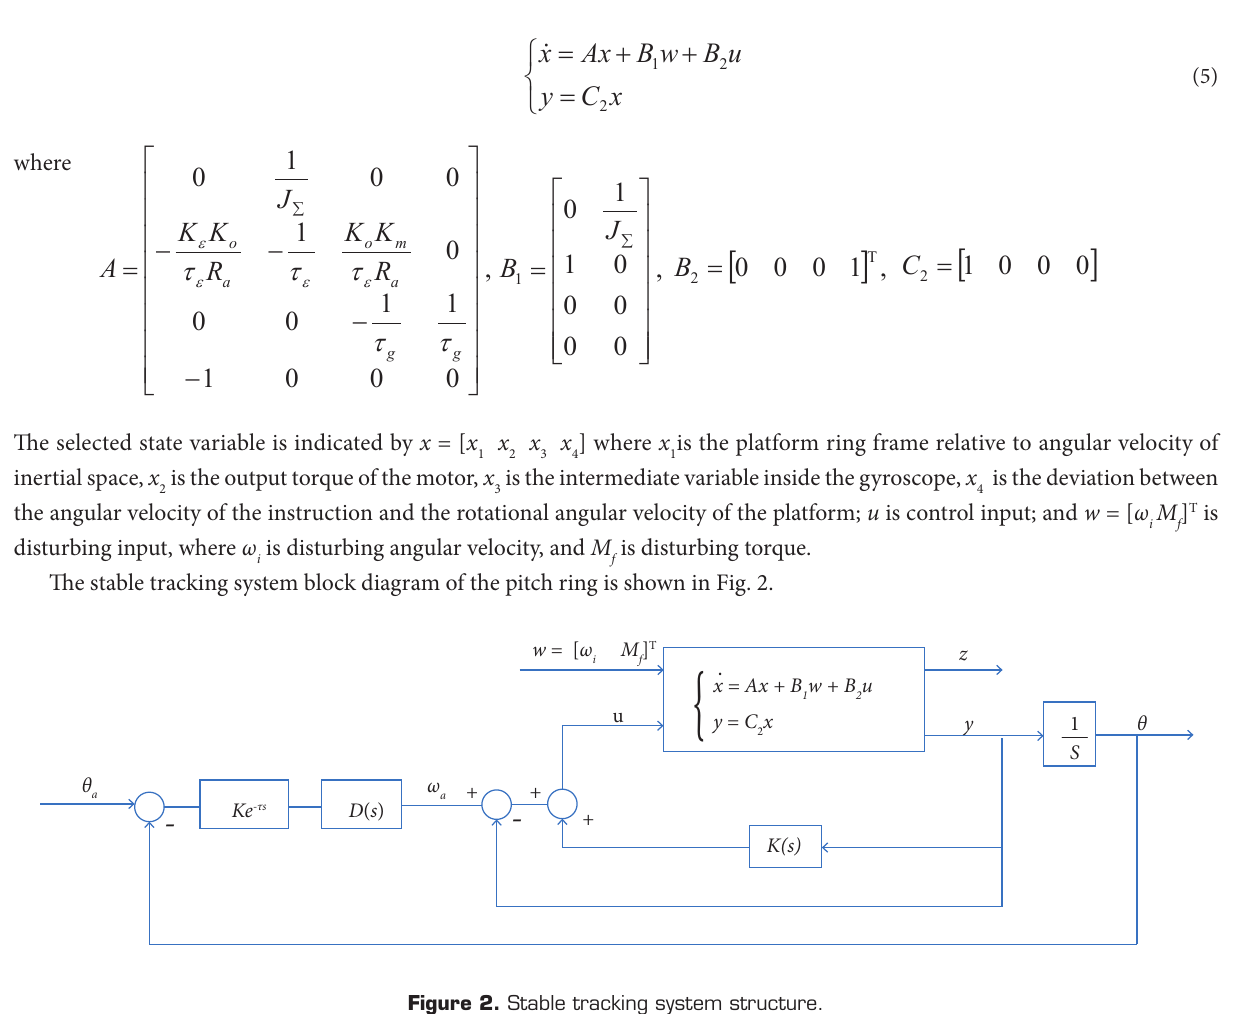
Figure 2. Stable tracking system structure.